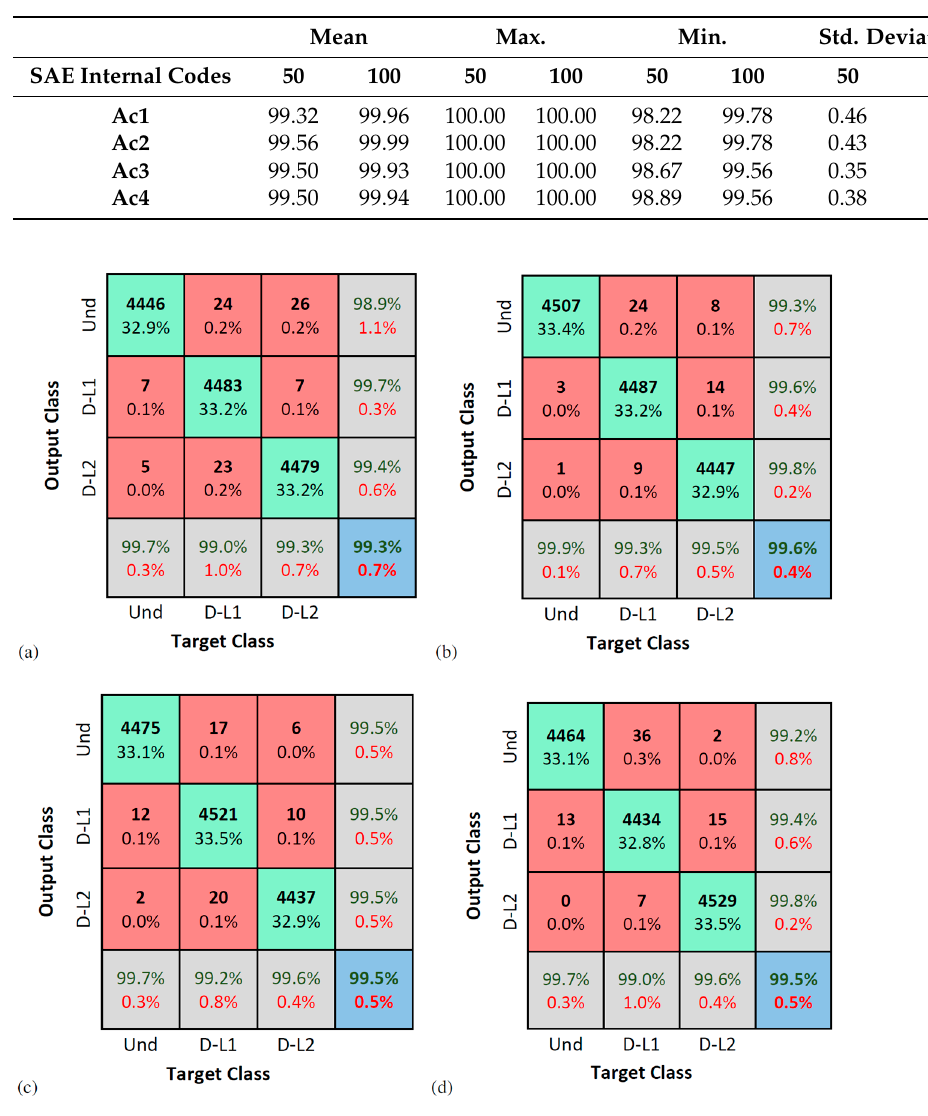
Figure 7. Simply supported numerical beam: Confusion matrices—50 SAE internal codes. ( a ) Meas- urement point Ac1. ( b ) Measurement point Ac2. ( c ) Measurement point Ac3. ( d ) Measurement point Ac4.